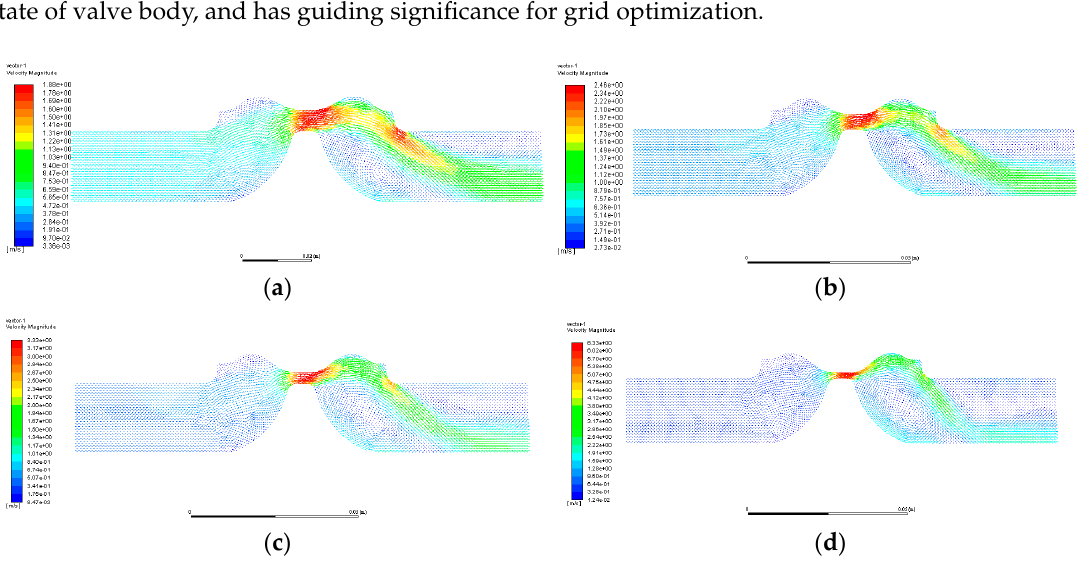
( b ) Figure 10. The meshes of three-time velocity adaptation ( a ) velocity gradient and y + hybrid adaptation; ( b ) and their results of calculation (Tables 2 and 3), respectively. Table 2. Result of Velocity gradient adaptive calculation. Initial Result